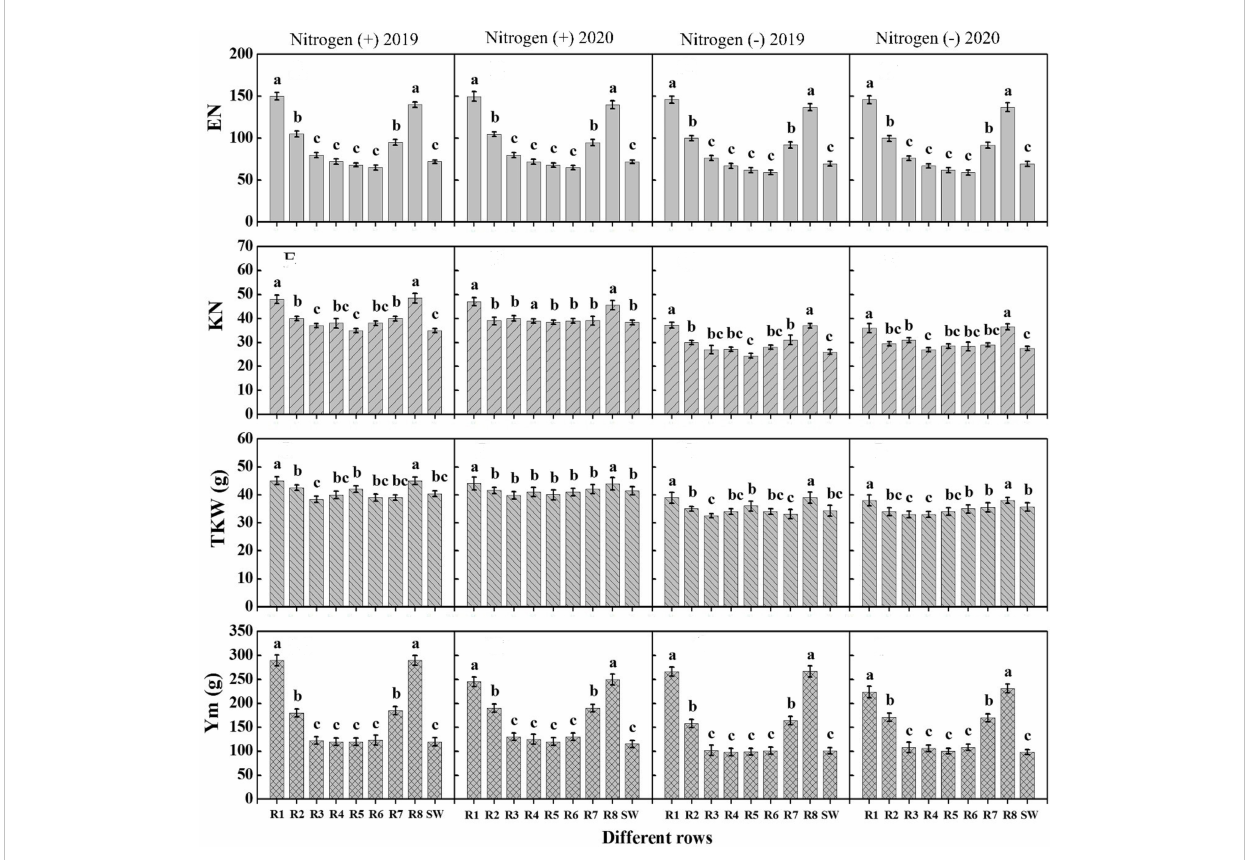
FIGURE 4 The kernel number per ear (KN), ear number per meter row (EN), thousand kernel weight (TKW, g) and per meter grain yield of different wheat rows under with- and without N application. Different letters on the top of each bar indicate signi fi cant differences among the crop rows, as calculated by Tukey ’ s HSD test at P ≤ 0.05. R, row; SW, sole